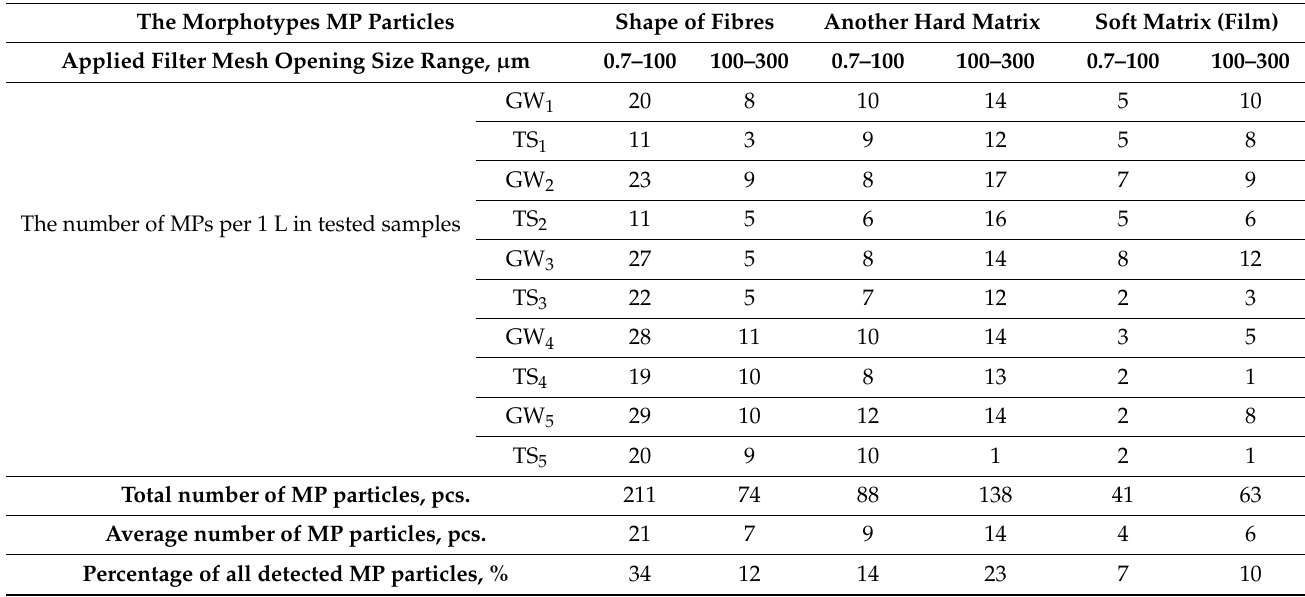
Table 1. The measured number of three identified morphotypes of MP particles depending on the Total number of MP particles, filter mesh size of grey water and treated sewage samples.